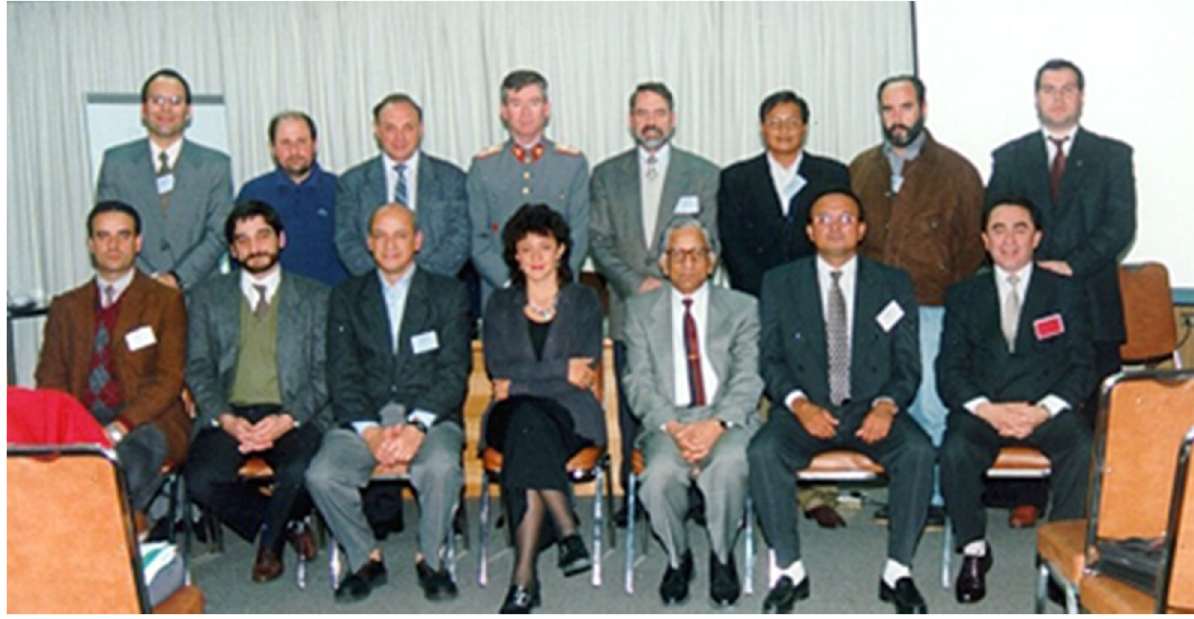
Figure 4: Participants of the SIRGAS WG III meeting, Santiago de Chile, August